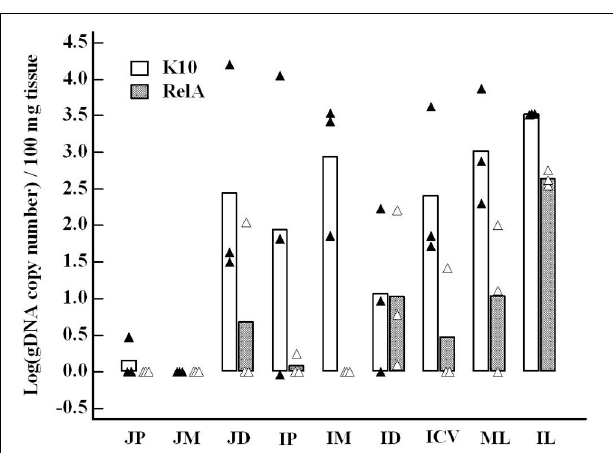
FIGURE 2 | Comparison of bacterial loads in each tissue site between K10 and RelA groups. Map gDNA copy number per 100mg tissue of each sample measured by IS900 qPCR was transformed to a log scale. The results were compared for the same tissue site between the two groups. Data are presented as the average of three animals of each group (bar graph) with all individual data (K10 group, closed triangle, and RelA group, open triangle, respectively). JP, JM, JD: jejunum proximal, middle, distal; IP, IM, ID: ileum proximal, middle, distal; ICV: ileocecal valve; ML,